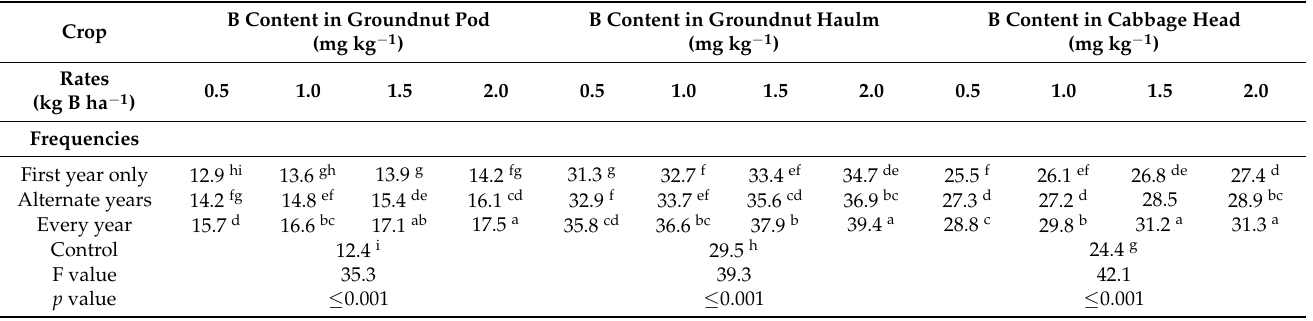
Table 2. Boron content in groundnut and cabbage crop under various dosages of B